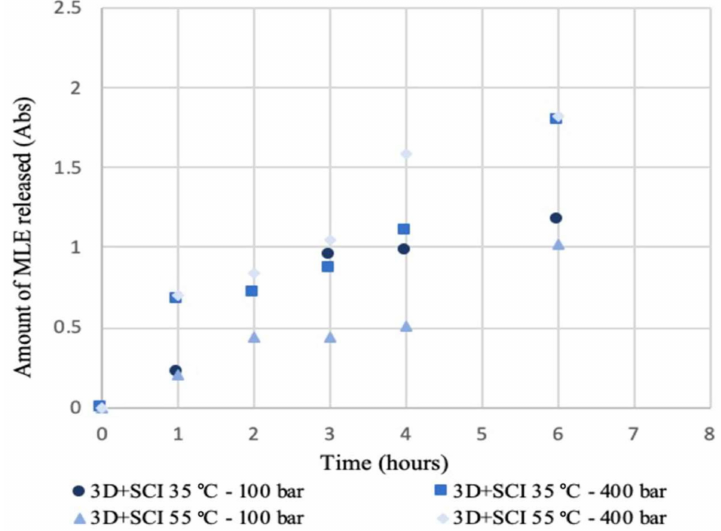
Figure 5. Release kinetics of 3D + SCI samples produced under different pressure and tempera- ture conditions.